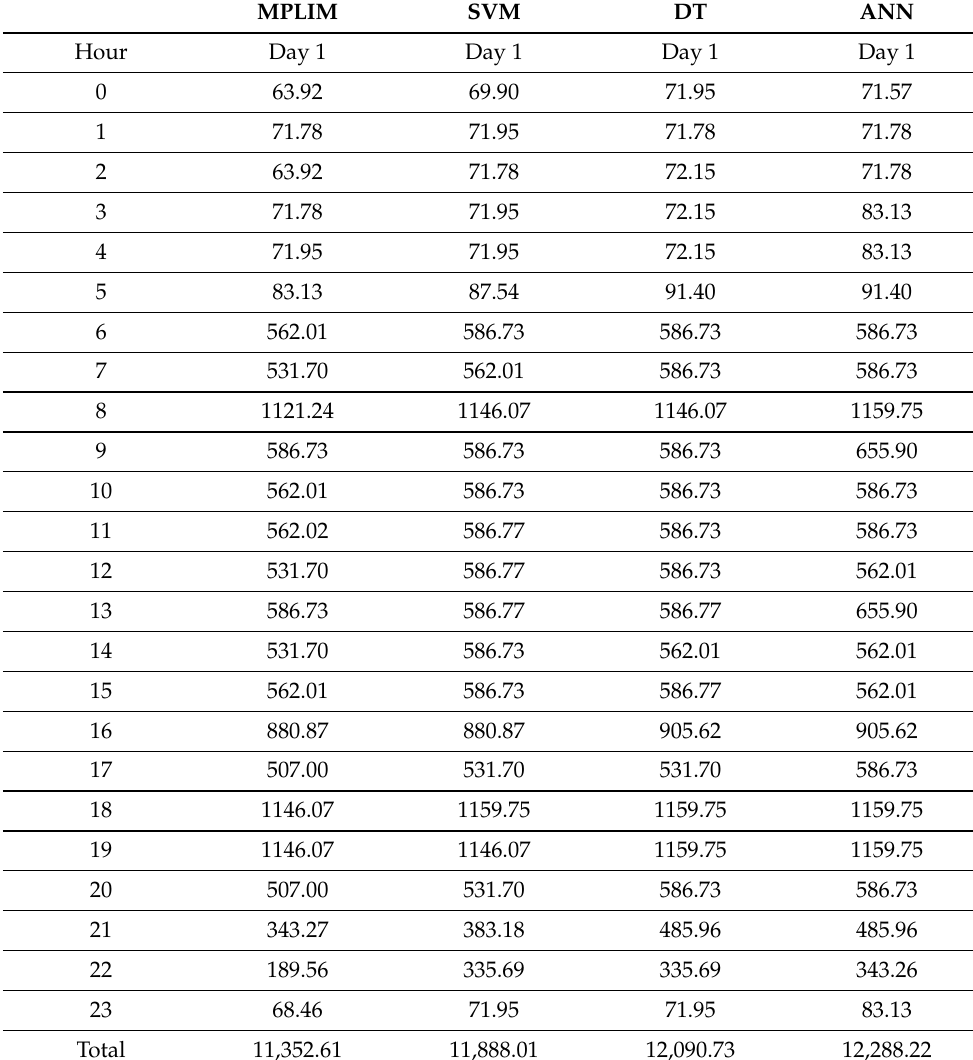
Table 4. Comparison of hourly energy loss results in kWh.